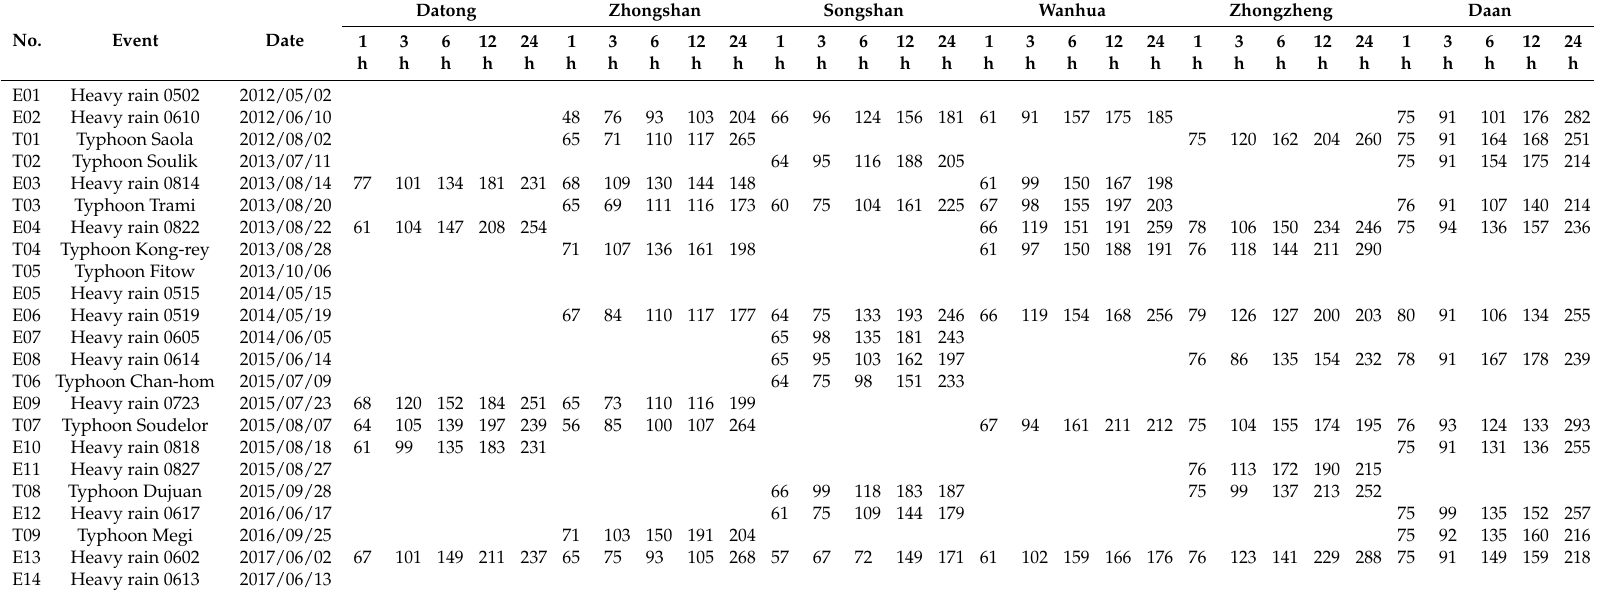
Table 8. ORTs with cross